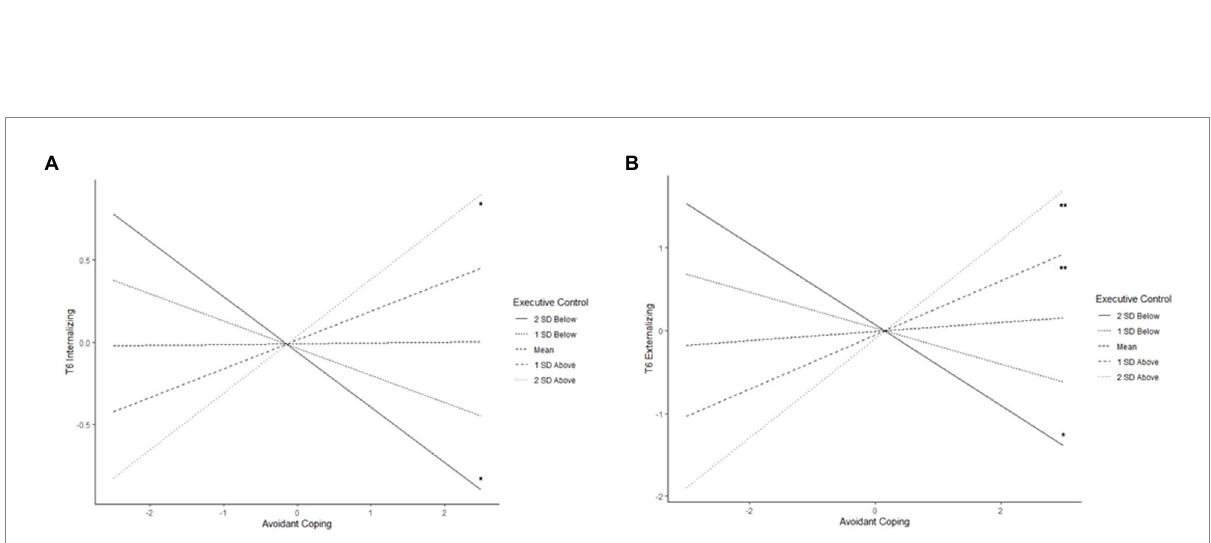
FIGURE 3 Executive control moderating the associations of (A) avoidant coping with T6 internalizing and (B) avoidant coping with T6 externalizing (* p < 0.05, ** p <